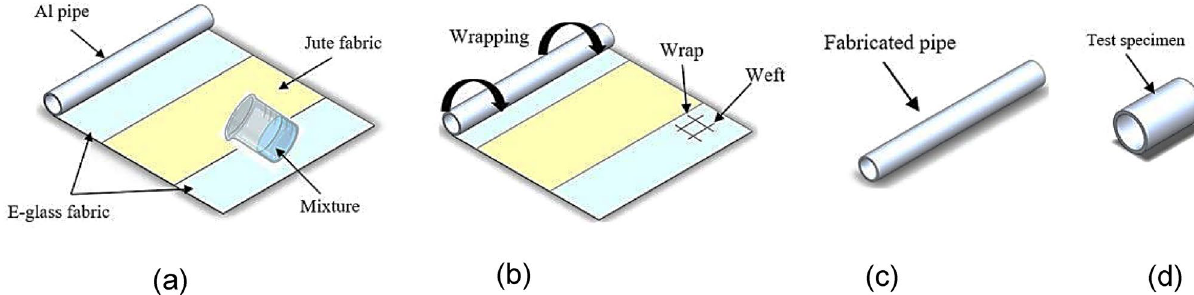
Figure 2. Manufacturing process sequence.